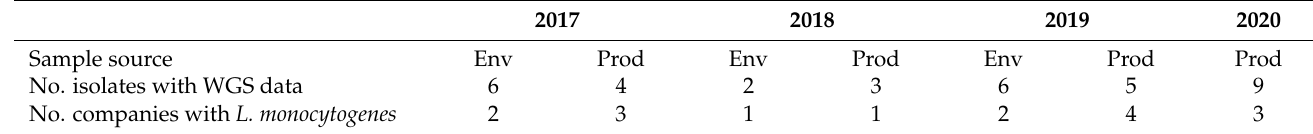
Table 2. Identification of additional Listeria monocytogenes isolates from the production environment